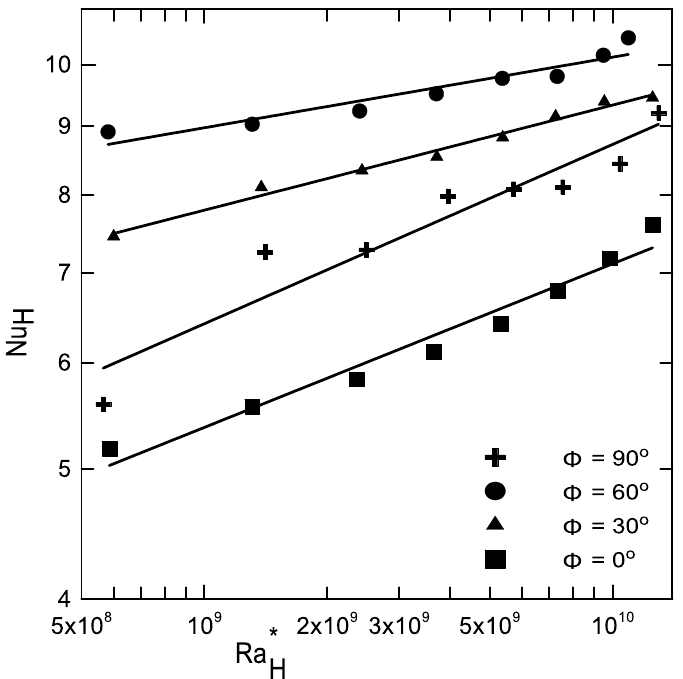
Figure 9. Nu versus 𝑅𝑎 H∗ for different inclinations. Fitting correlations are presented by solid lines.